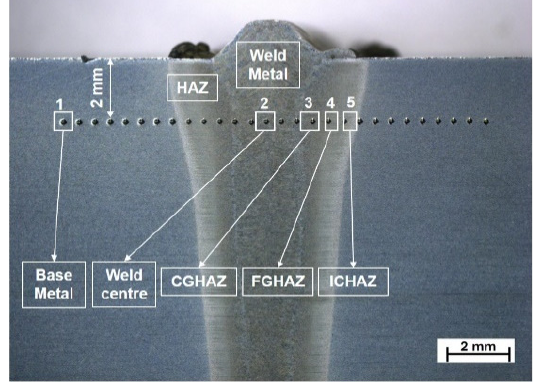
Figure 4. Schematic photograph from welded cross section showing the areas where SEM micro- graphs were taken (2% Nital).